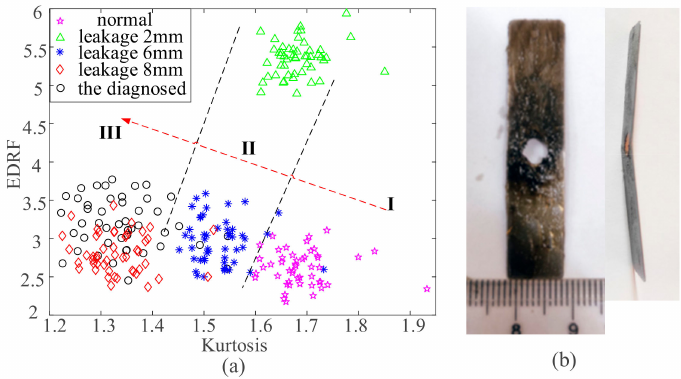
Figure 17. Diagnosis e ff ect of actual valve leakage fault; ( a ) fault diagnosis e ff ect, ( b ) the disassembled leakage fault